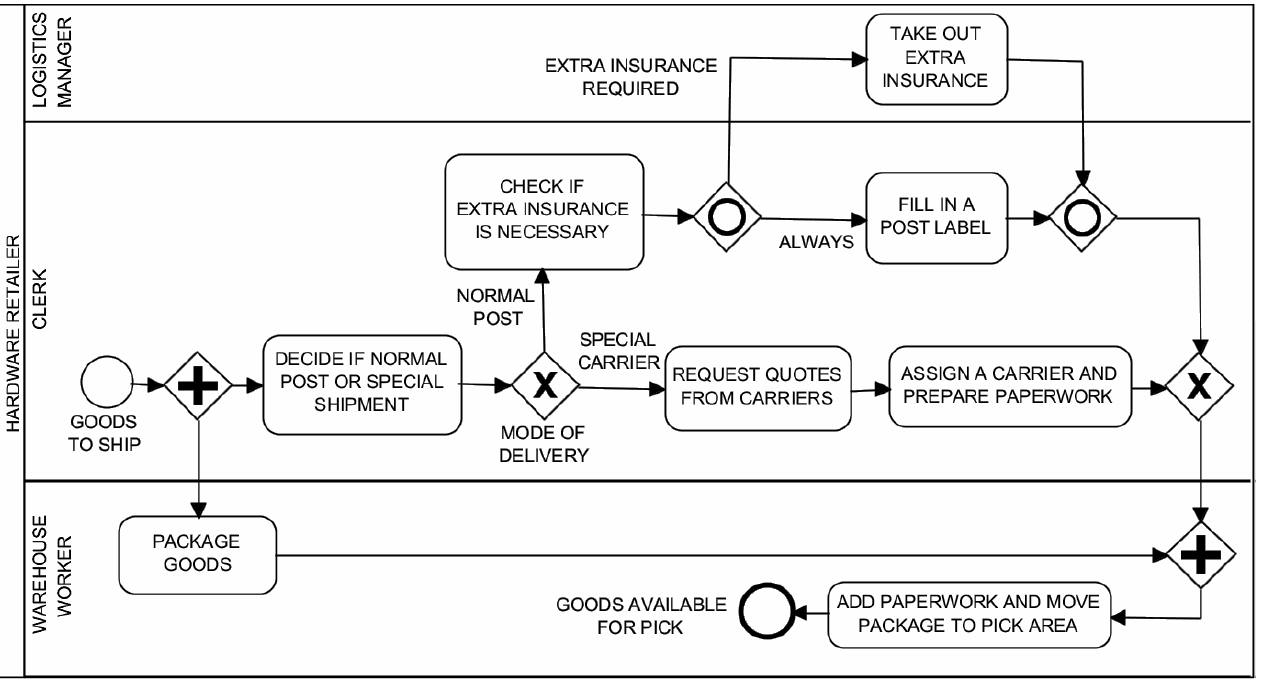
Figure 12. Shipment process of a hardware retailer: BPMN process